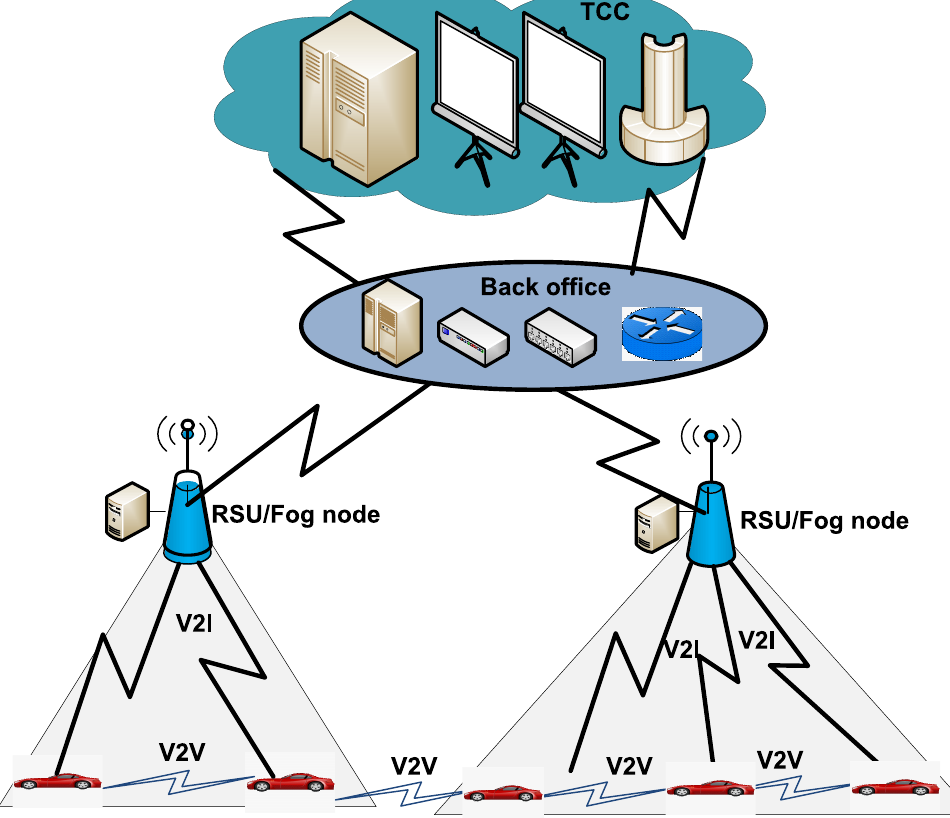
Figure 2. An architecture of vehicular networks (here, TCC: Traffic Command